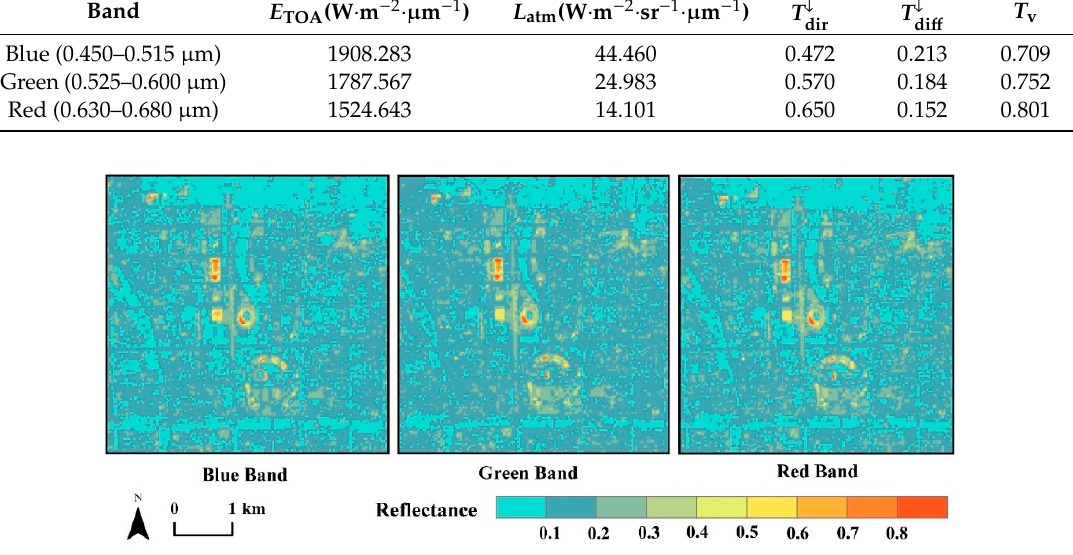
Figure 5. Urban 3D surface reflectance derived from the urban solar radiative transfer (USRT) model using Landsat 8 data within the study